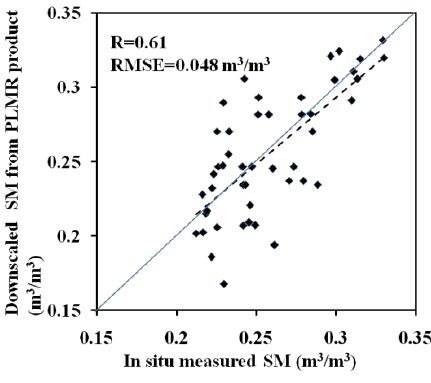
Figure 6. The scatter plots between in situ measurements and the downscaled SM from PLMR SM products for 10 July. R represents the correlation coefficient between in situ observations and the downscaled